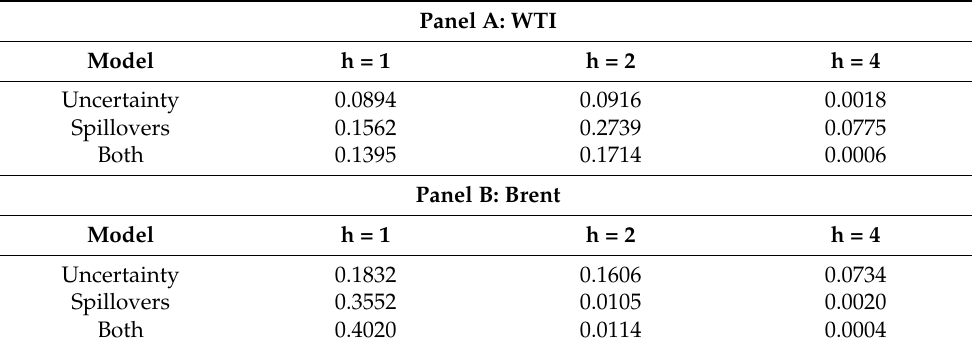
Table 5. Forecasting results for a rolling-estimation